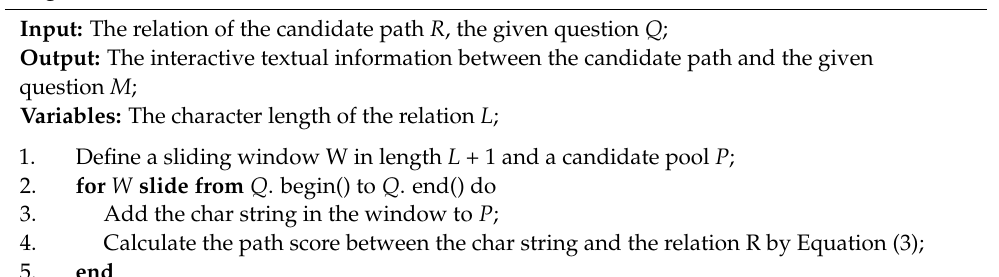
Algorithm 1 : The calculation method of interactive textual information